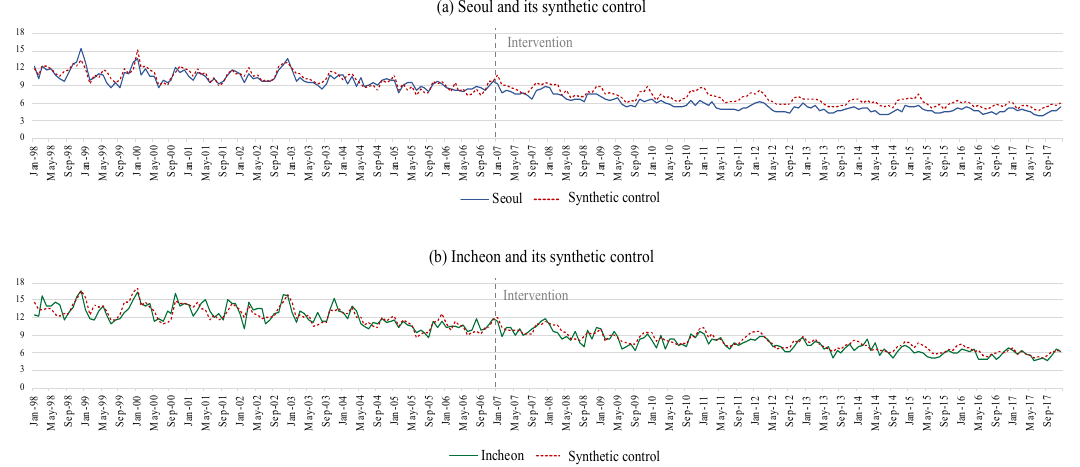
Figure 3. Monthly age-standardized cardiovascular mortality rate (per 100,000) in Seoul, Incheon and synthetic controls. Table 2. Normalized root mean squared errors (NRMSEs) in synthetic controls and Daejeon. Seoul